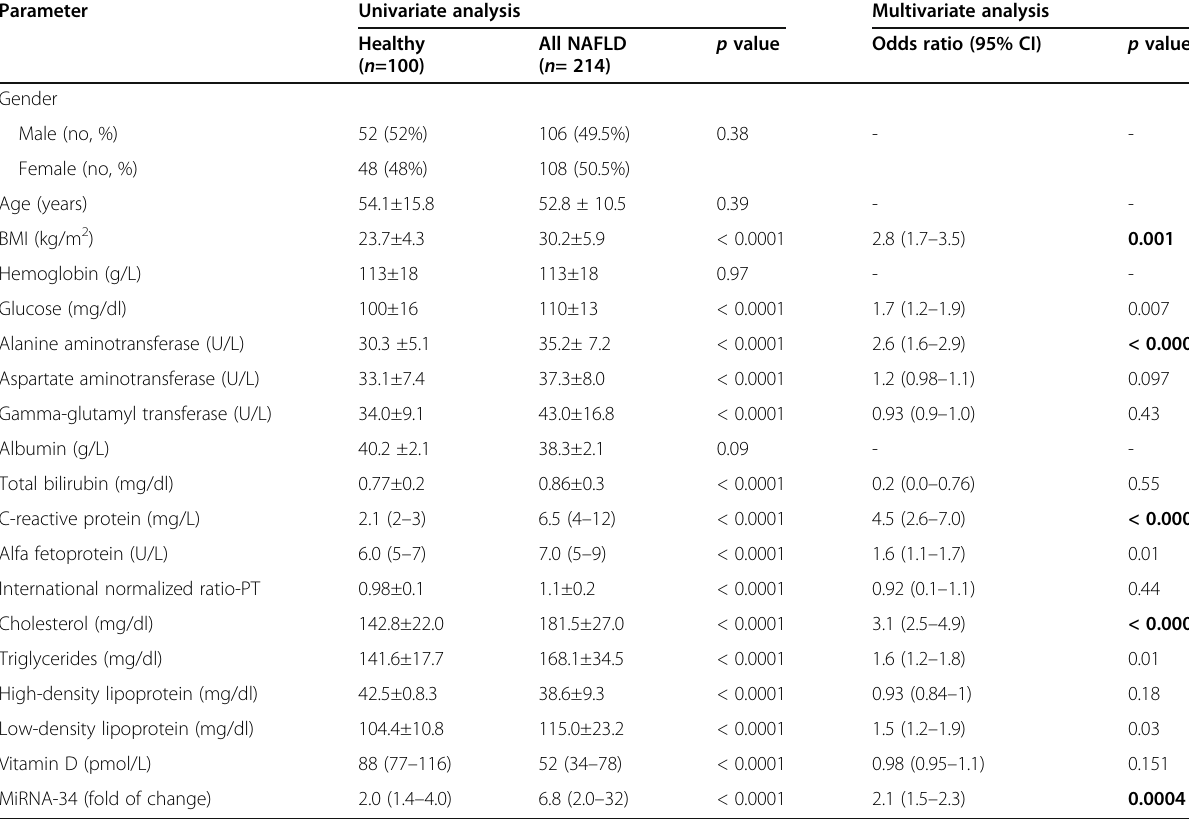
Table 1 Demographic and laboratory features of the studied groups